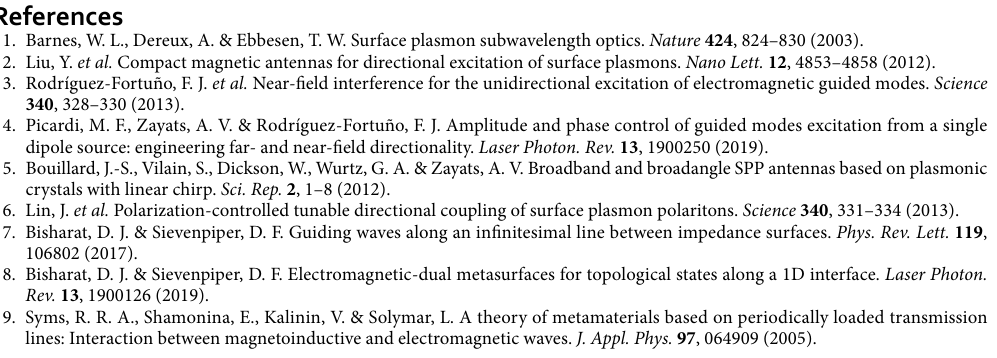
Figure 13. Switchable unidirectional power flow in a metasurface at ω above a 10 10 planar metasurface, with four central elements driven (marked as black circles) to yield a single × beam ( a ), two beams ( b ), three beams ( c ) and four beams ( d ). Analytical model for κ x and using circular-shaped elements, shown with grey